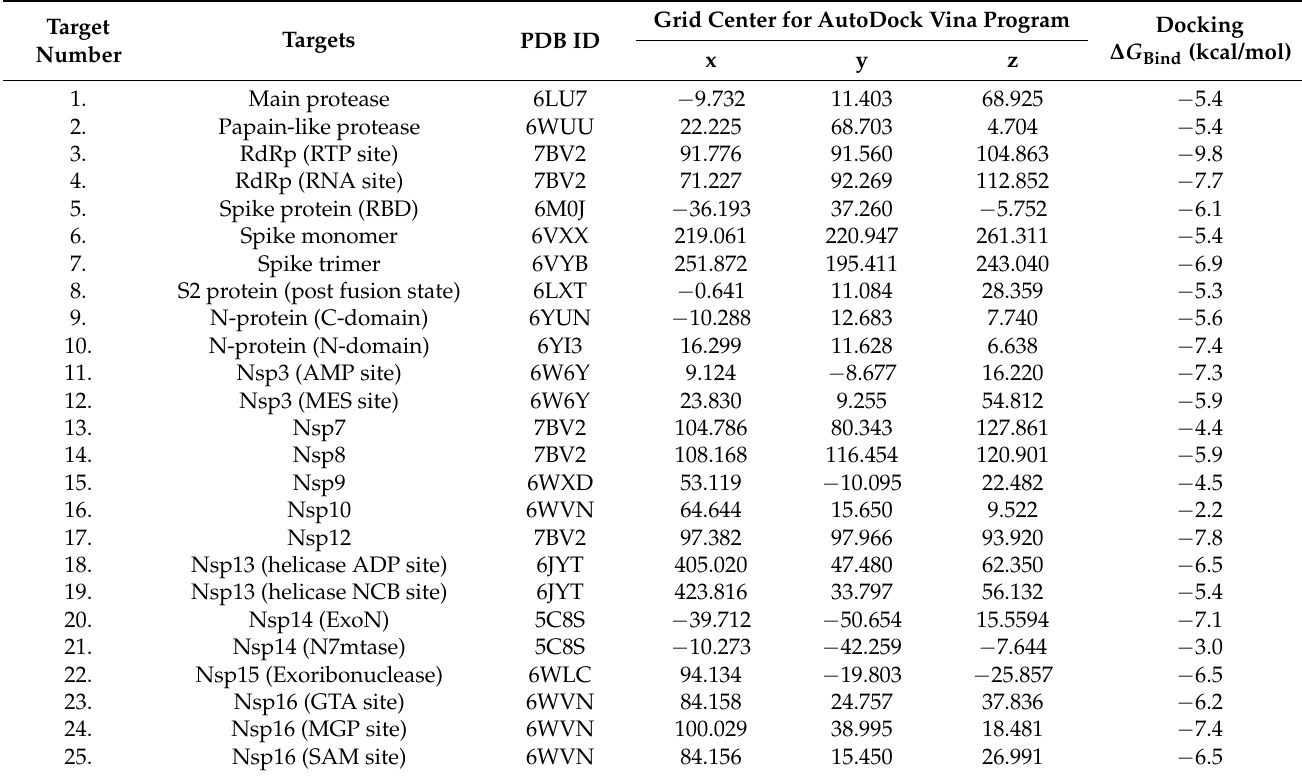
Table 1. Docking-predicted binding energy ( ∆ G Bind ) and grid parameters used for docking of teicoplanin with 25 potential COVID-19 drug